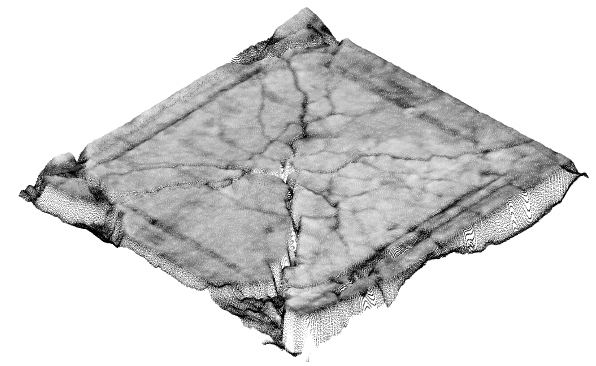
Figure 7. Point cloud of test plate scanned with PPS-Plus.